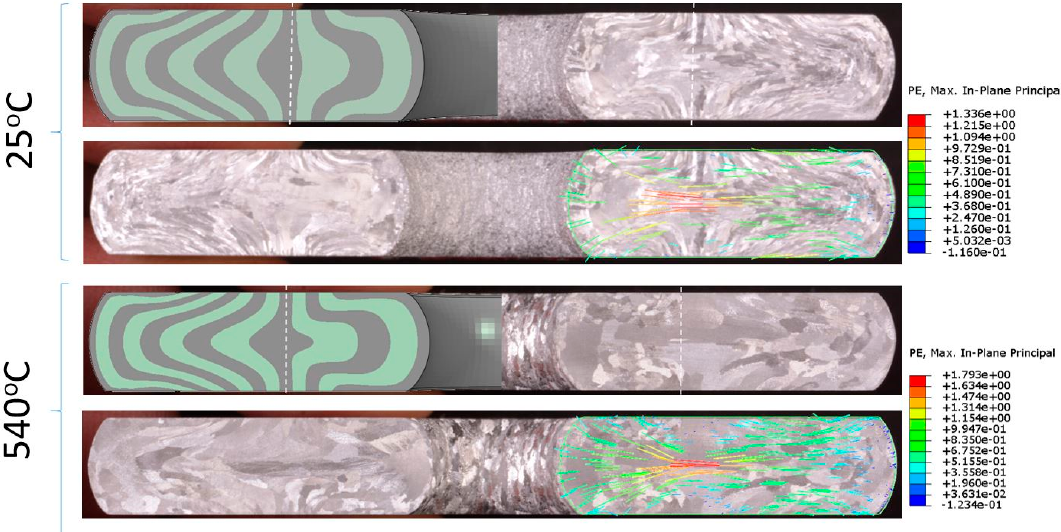
Figure 12. Comparison between predicted and experimental ring neutral radius and flow patterns for specimens R2 ( top ) and R8 ( bottom ), which represent the effect of temperature for unlubricated rings loaded at V = 1200 mm/min.